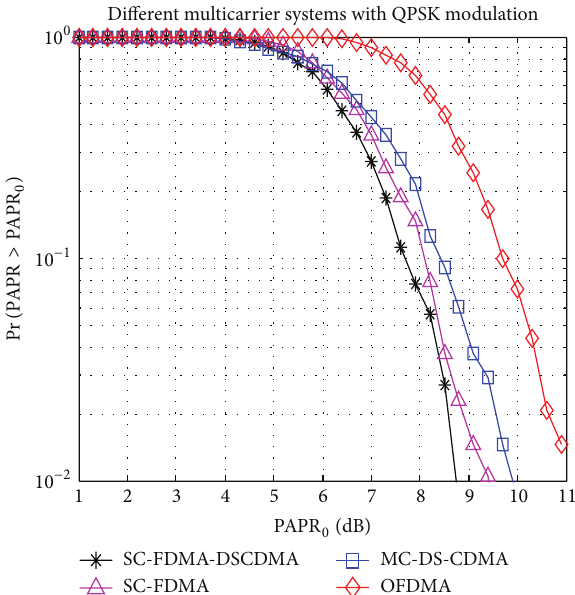
Figure 6: PAPR performance of the proposed SC-FDMA- DSCDMA technique compared with other multicarrier techniques. QPSK modulation with FFT size being 256. PAPR performance of the proposed technique is best: 1dB better than SC-FDMA and 2 dB better than Luo and Xiong